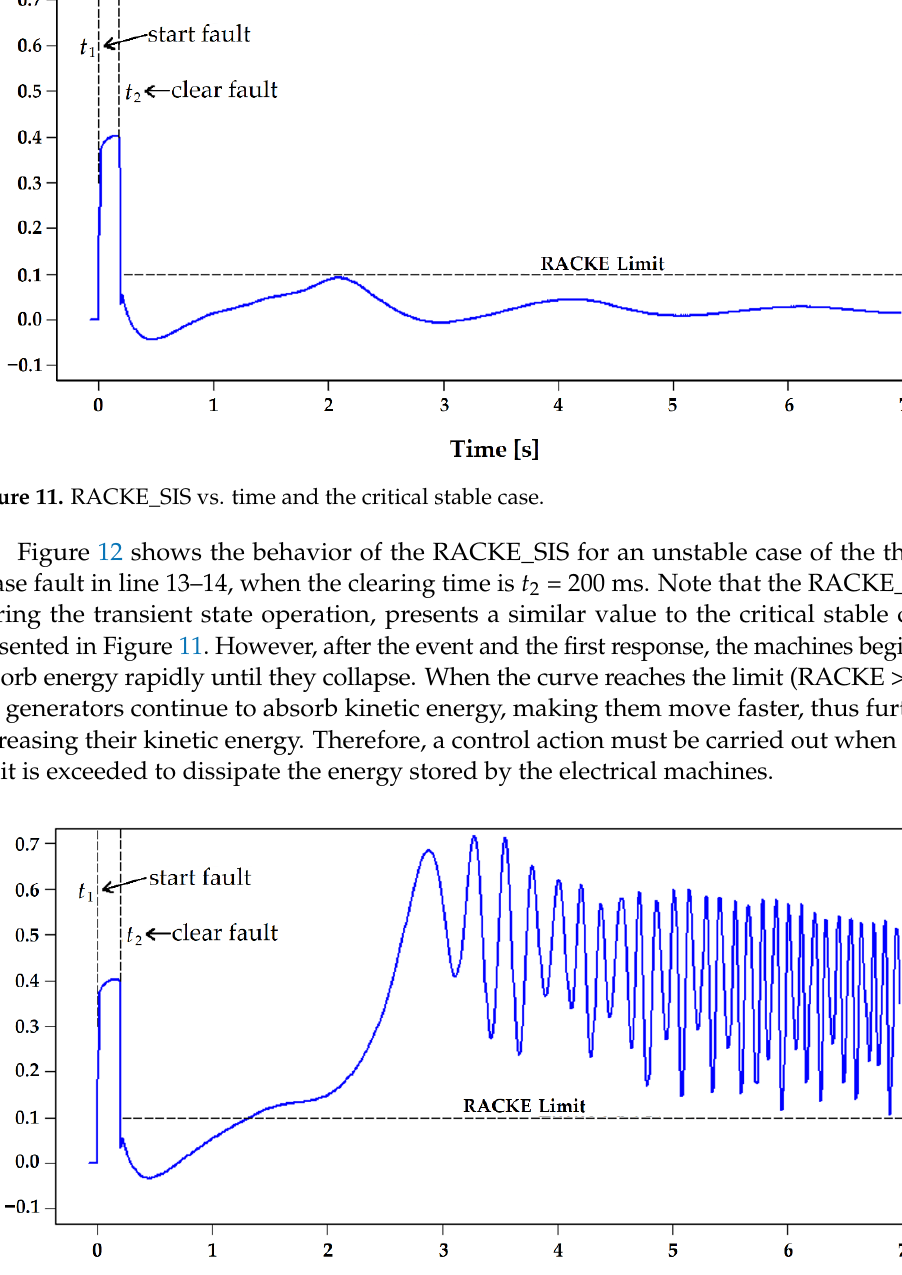
Figure 10. Rotor speed of the generator in an unstable case.